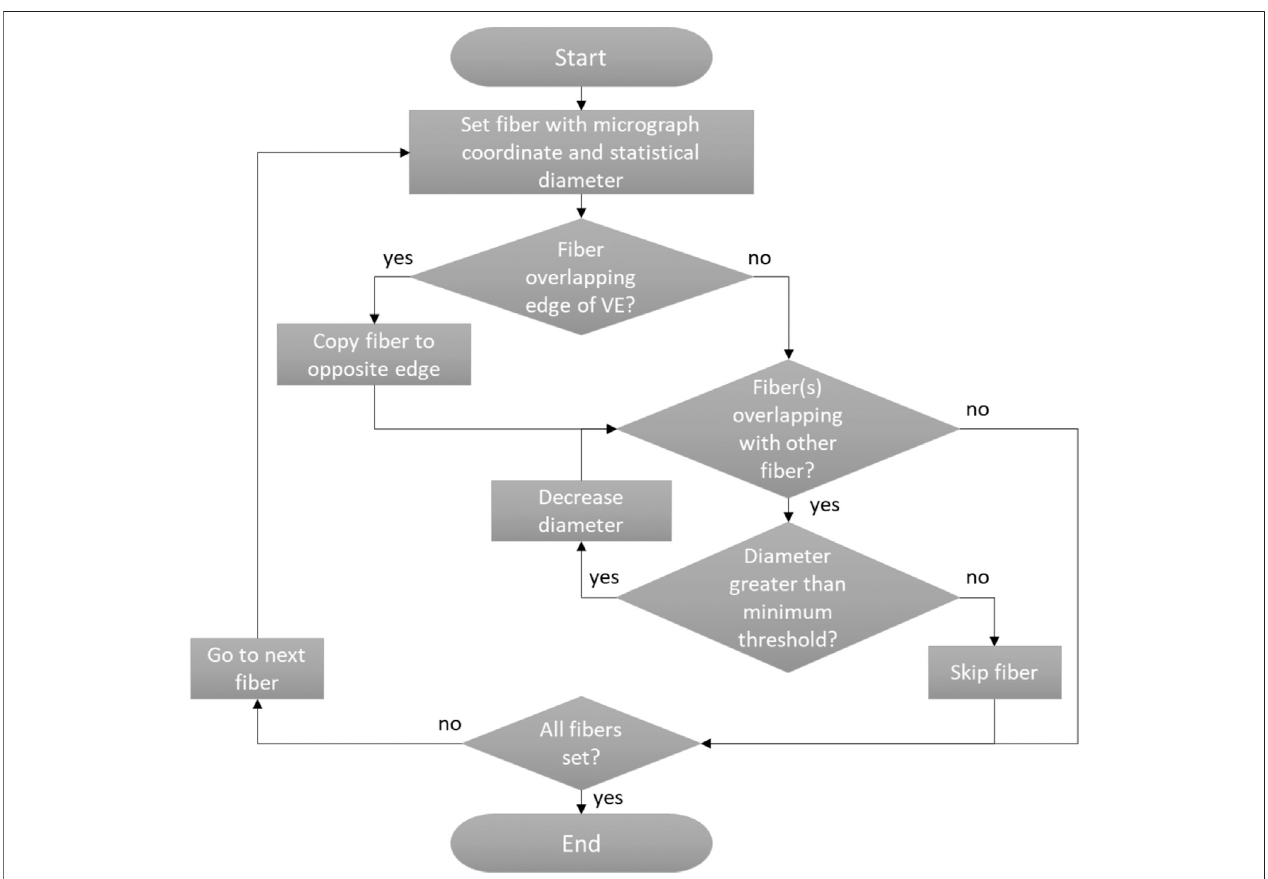
FIGURE 4 | MVE generation algorithm using micrograph coordinates and guaranteeing periodicity.